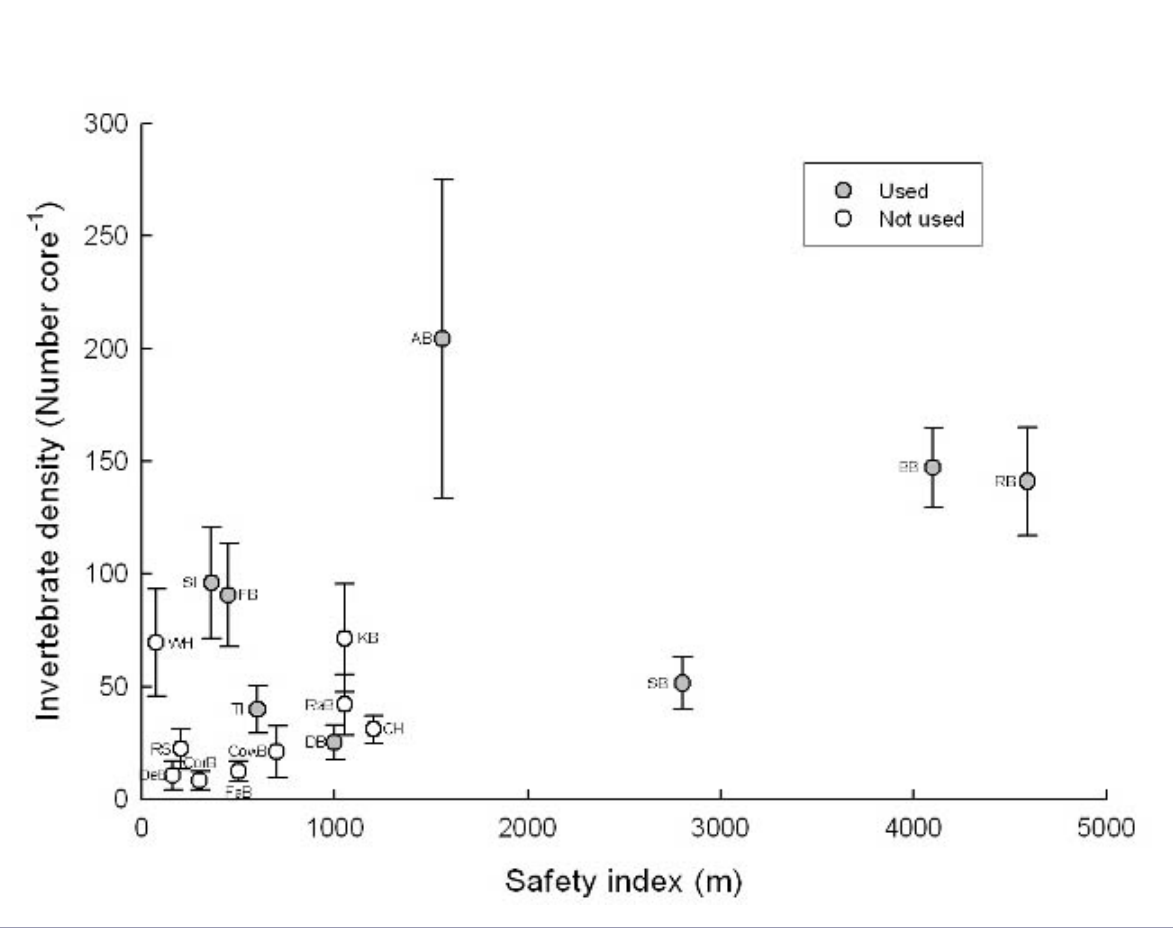
Fig. 2. The mean invertebrate density (± 95% C.I.) and safety index for sites that are used and not used by Western Sandpipers on